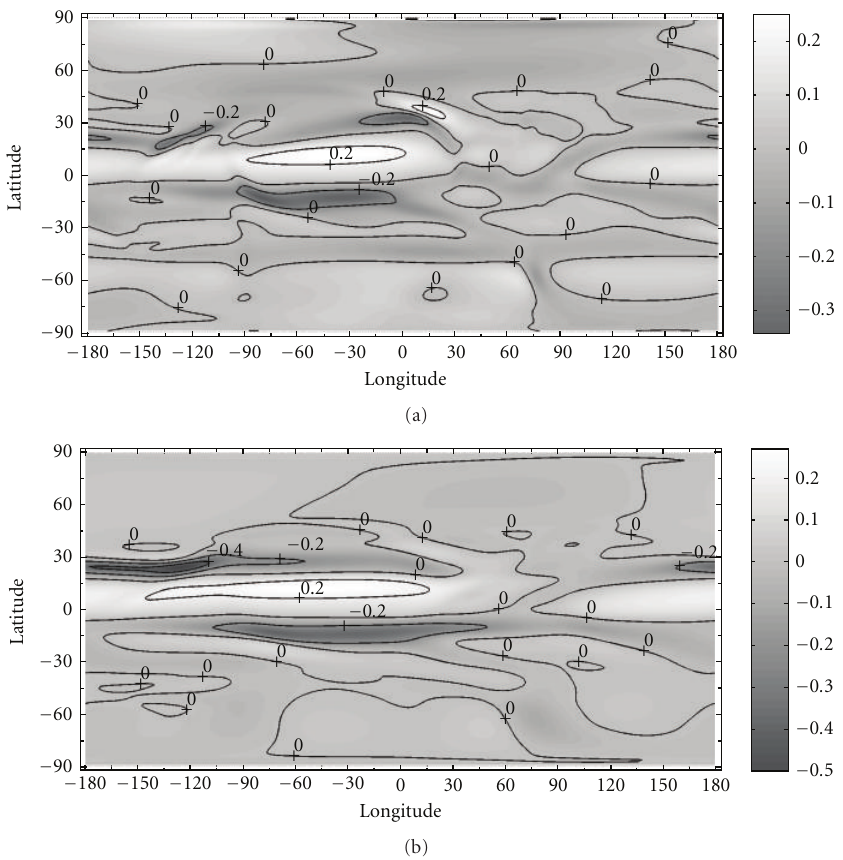
Figure 6: The global distributions of the simulated vertical component of the neutral wind velocity at the altitude of 50 km, obtained for 16 January and calculated for two distinct values of solar activity: F 10 . 7 = 101 (a) and F 10 . 7 = 230 (b). The velocities are given in m/s, with positive direction of the vertical velocity being